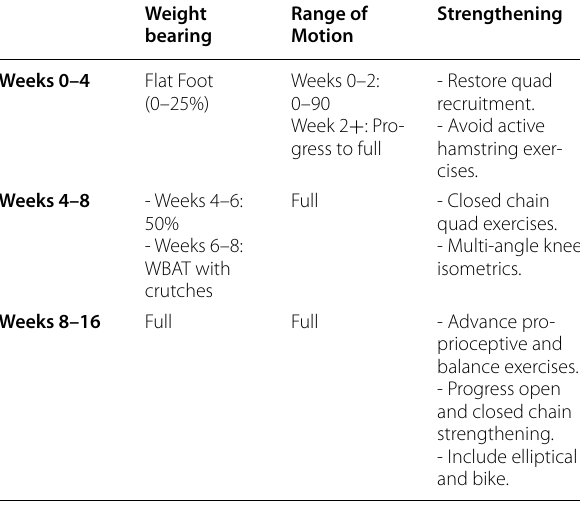
Table 2 Post-operative restrictions following anterior closing wedge proximal tibial osteotomy Weight Range of bearing Motion